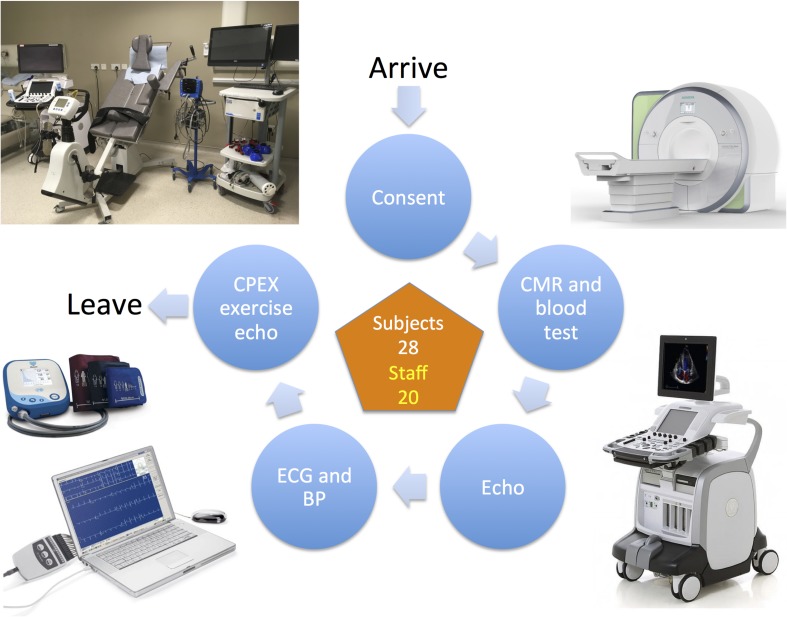
The study visit testing circuit. BP, blood pressure; CMR, cardiac magnetic resonance; CPEX, cardiopulmonary exercise test; ECG, electrocardiogram.